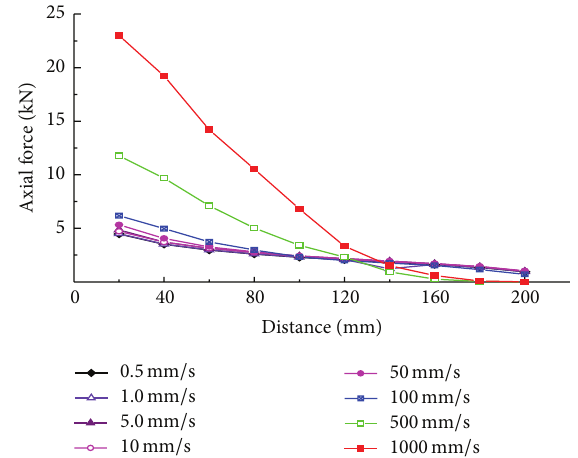
Figure 7: Changes of axial force under different loading rates.